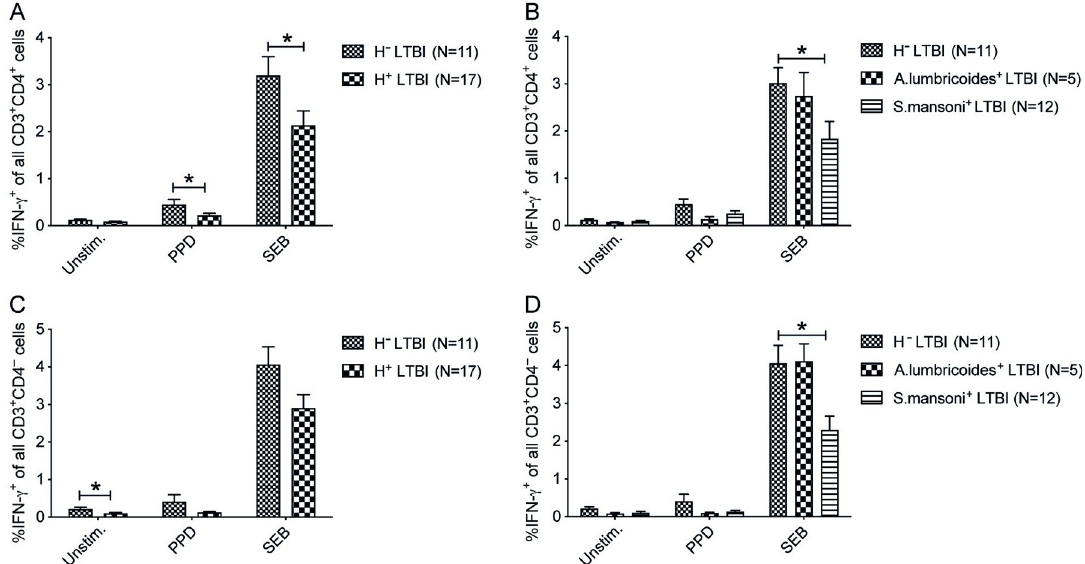
Fig 3. S . mansoni infection suppresses IFN- γ producing capacity by CD3 + T cells in LTBI positive individuals. PBMCs from helminth negative and helminth positive LTBI individuals were ex vivo stimulated with PPD, SEB, or left unstimulated (Unstim.) and incubated with Brefeldin A for analysis of IFN- γ producing T cell by flow cytometry. Frequency of IFN- γ + CD4 + cells of all CD3 + CD4 + cells in helminth negative (H - LTBI) and combined A . lumbricoides and S . mansoni positive (H + LTBI) (A), H - versus specific helminth infection (B). Frequency of IFN- γ + CD4 - cells of all CD3 + CD4 - cells in H - LTBI versus H + LTBI (C), and H - LTBI versus specific helminth infection (D). Data presented as mean ± SEM, and Student’s t-test was used to analyze the differences between H - LTBI and H + LTBI whereas one-way ANOVA following Tukey’s multiple comparison test was used to assess the species-specific effect. � , p <